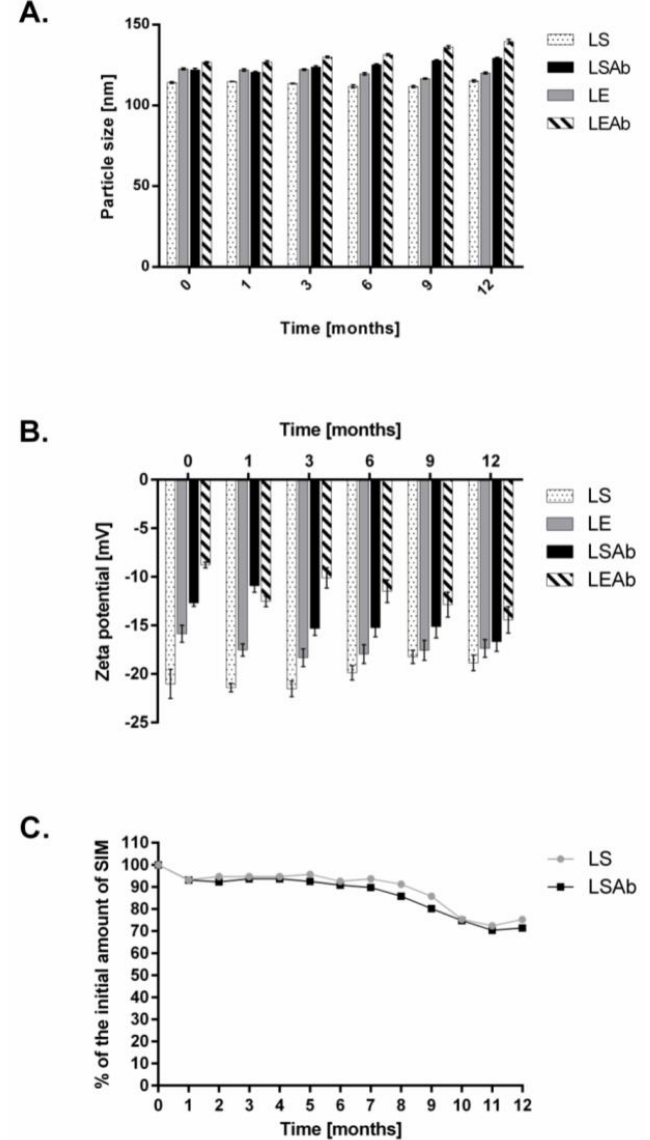
Figure 2. Stability of targeted and non-targeted liposomes during 12 months of storage as a suspension. Both liposomal and immunoliposomal formulations of simvastatin were stored at 4 °C. After every month, changes in liposome diameter ( A ), zeta potential ( B ) and simvastatin content ( C ) were measured. LS — non-targeted liposomes with simvastatin, LSAb — immunoliposomes with simvastatin, LE — non-targeted empty liposomes, LEAb — empty immunoliposomes.